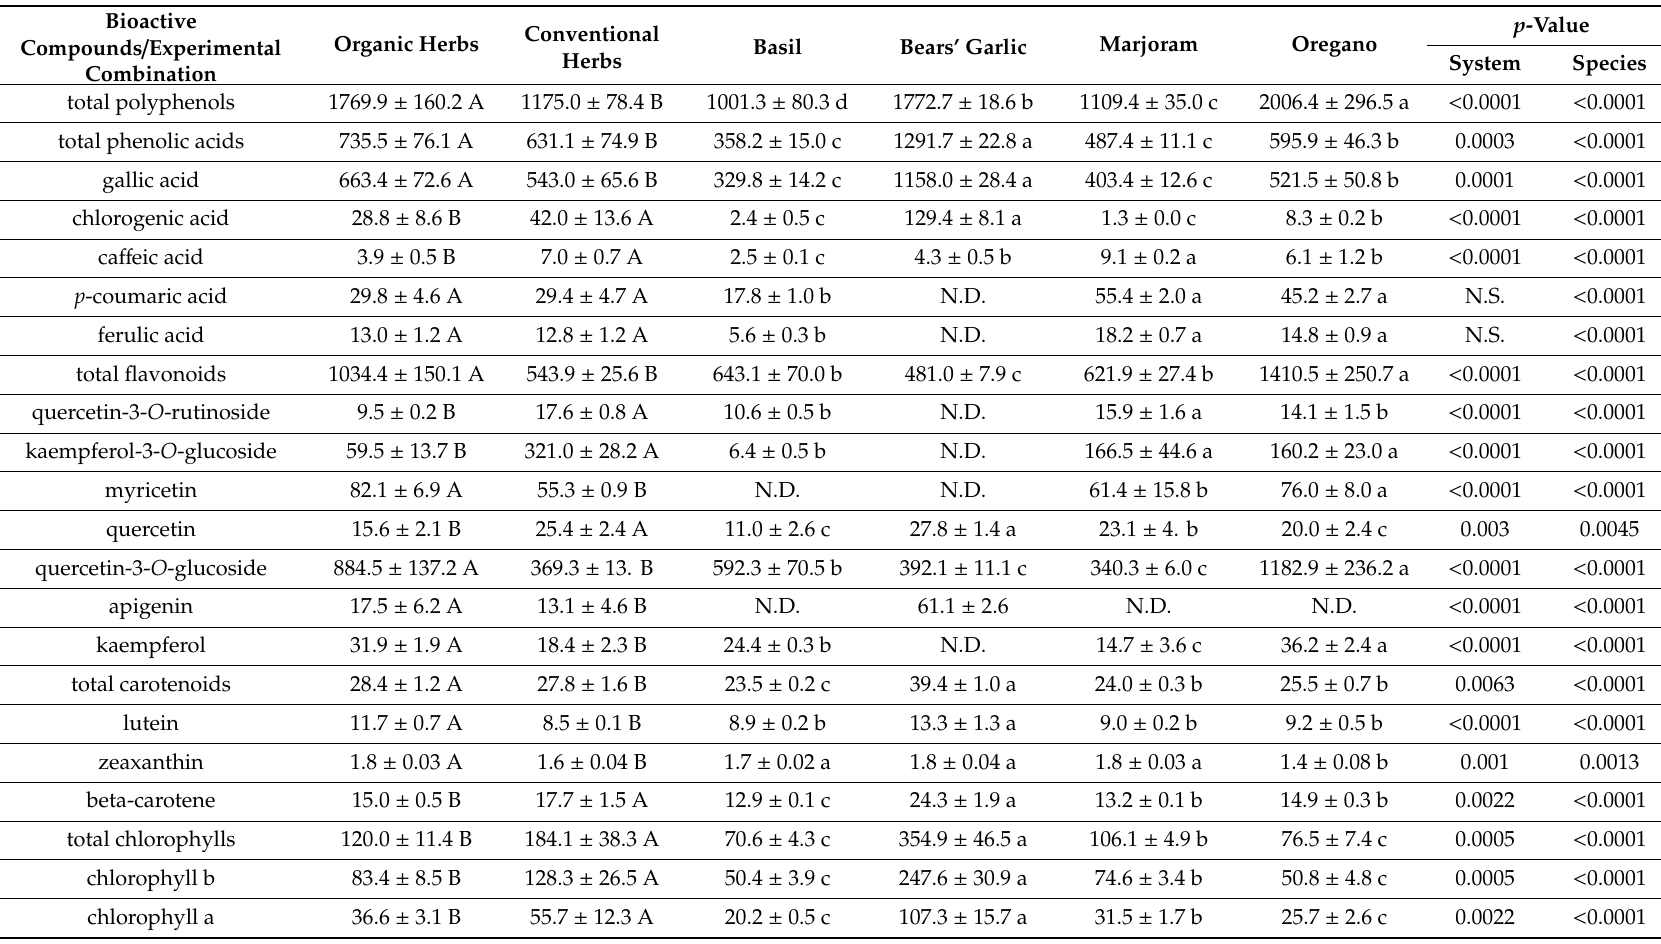
Table 1. The content of bioactive compounds (in mg 100 g − 1 of product) in selected spices from organic and conventional production in